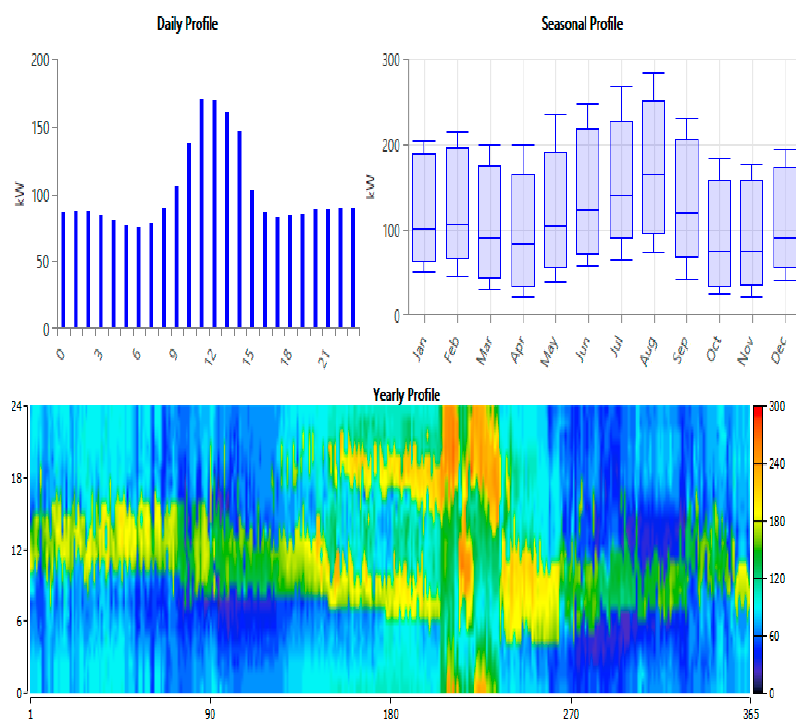
Figure 2. Load profile of Al Sulaymaniyah village.